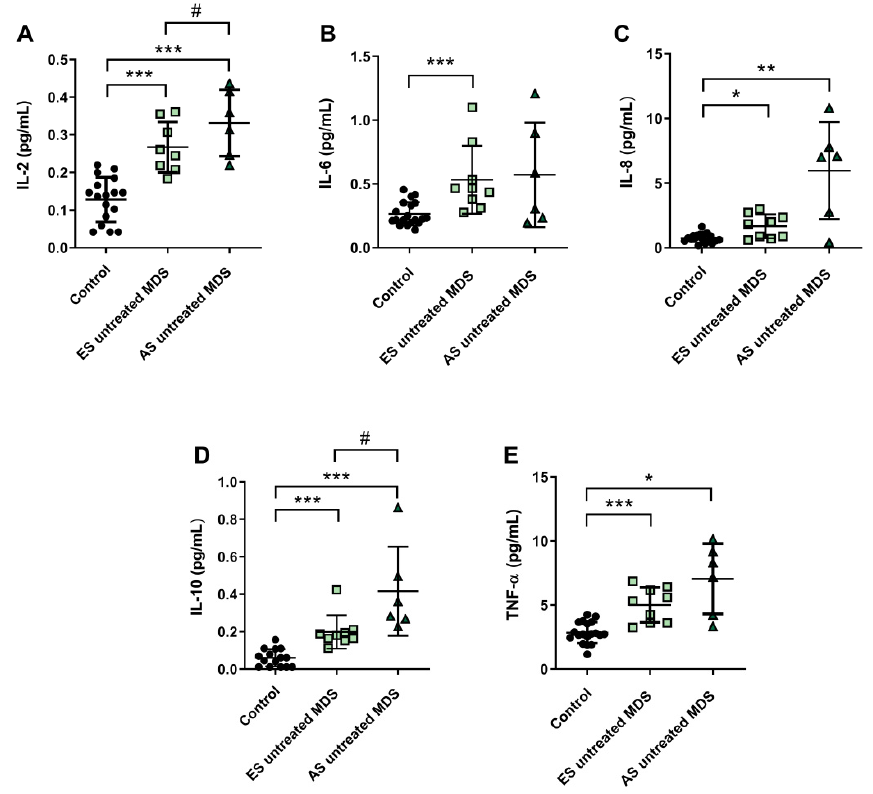
Figure 4. Concentration of pro- and anti-inflammatory cytokines during myelodysplastic syndrome (MDS) progression. ( A ) IL-2, ( B ) IL-6, ( C ) IL-8, ( D ) IL-10 and ( E ) TNF- α plasma concentration in early stage (ES untreated MDS) vs. advanced stage (AS untreated MDS) from untreated MDS patients. * p < 0.05, ** p < 0.01, *** p < 0.001 vs. control; # p < 0.05 vs. ES untreated MDS group.